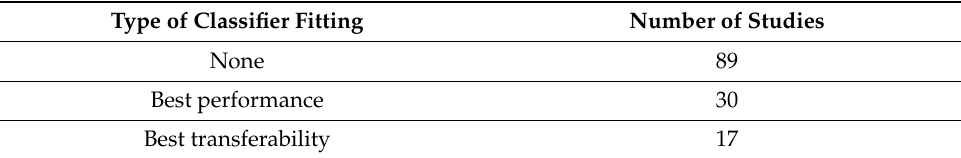
Table 7. Number of studies reviewed using a classifier fitting to classify natural